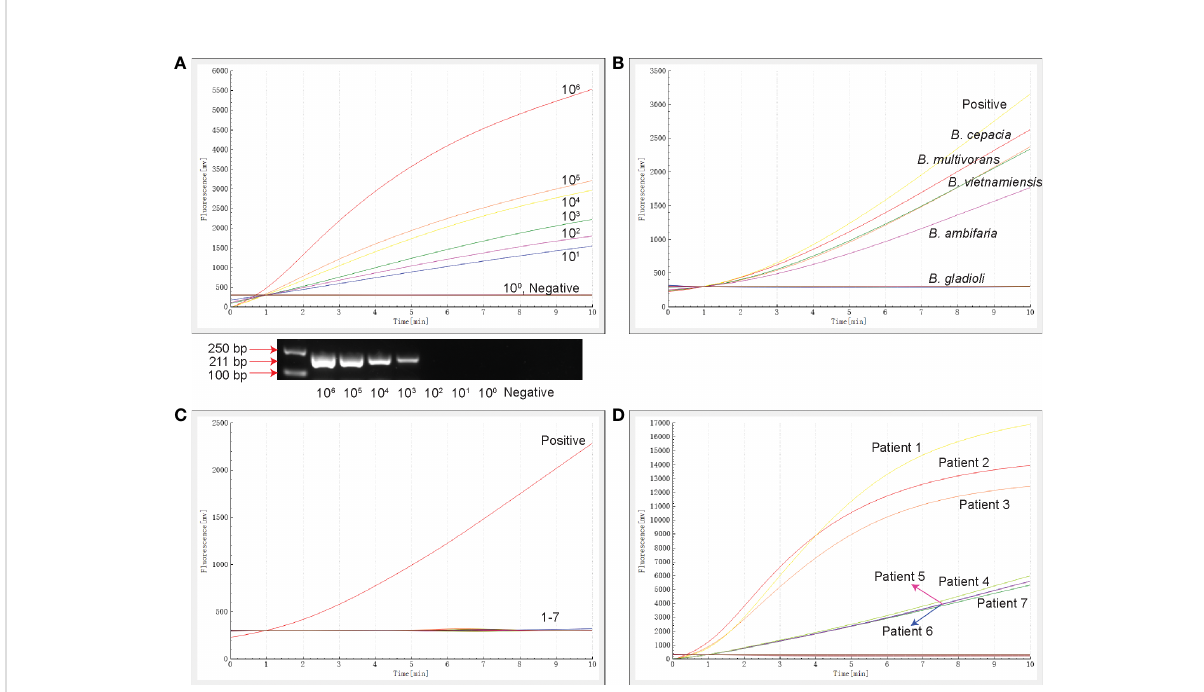
FIGURE 2 The sensitivity, speci fi city and clinical testing of the RAA assay. (A) The sensitivity of RAA and conventional PCR assays. The results of RAA are shown by an ampli fi cation curve, and the PCR ampli fi cation products are shown following separation on a 1.5% agarose gel. (B) The speci fi city of the RAA assay for members of the Burkholderia family. (C) The speci fi city of RAA for clinically-common pathogens. 1: Haemophilus in fl uenzae ATCC10211, 2: M. tuberculosis ATCC25618, 3: Staphylococcus aureus ATCC29213, 4: Pseudomonas aeruginosa ATCC27853, 5: K. pneumoniae ATCC BAA-2146, 6: E. coli ATCC25922, 7: Mycoplasma pneumoniae M129 ATCC 29342. (D) Seven samples tested positive by the RAA assay. The positive control was 16S rRNA -positive plasmid, and the negative control was nucleic acid-free